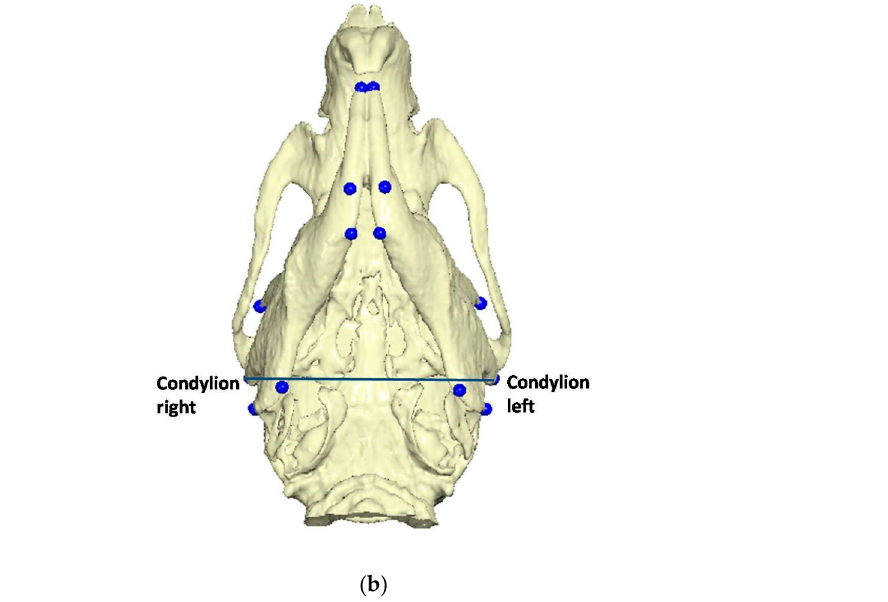
Figure 3. ( a ) Linear measurements: Go’–Menton (mandibular body length a); Go–Menton (mandibular body length b); Coronoid–Menton; Condylion/Go’–Menton (Condylion height); Condylion–Go’ (Ramus height); Condylion–Menton; Condylion–Id; Condylion–I’ (mandibular length); Incisal–Id; Incisal–I’. ( b ) Linear measurement: Condylion right–Condylion left (Intercondylar distance).